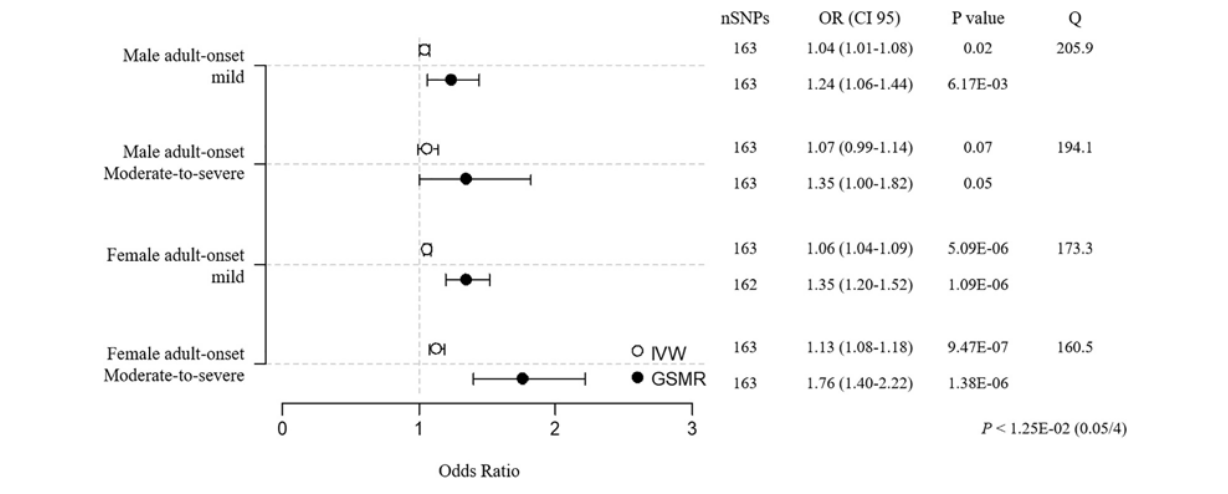
FIGURE 4 | MR estimates of associations between BMI and adult-onset asthma subtypes. The odds ratio is plotted as dots with the 95% confidence interval. White dots are the IVW method, and black dots are the GSMR method. The P value indicates significance when P < 1.25E-02 (0.05/4) by Bonferroni correction. The Q value by Cochran’s Q statistic indicates residual heterogeneity in the MR